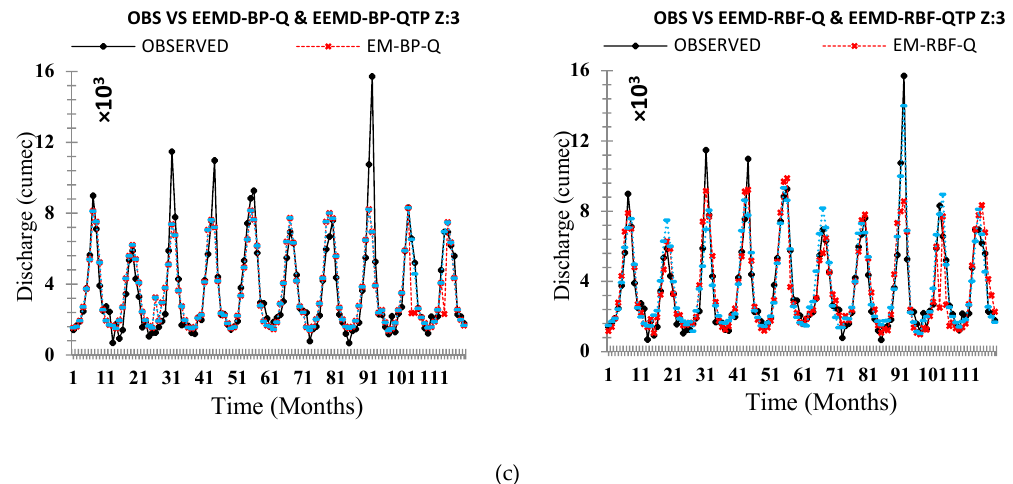
Figure 16. Comparison of the originally observed streamflow and the simulated runoff hydrograph Zone Three ( a ) OBS VS ANN (Q & QTP) Inputs, ( b ) OBS VS ANN-DWT (Q & QTP) Inputs, and ( c ) OBS VS ANN-EEMD (Q & QTP) Inputs.